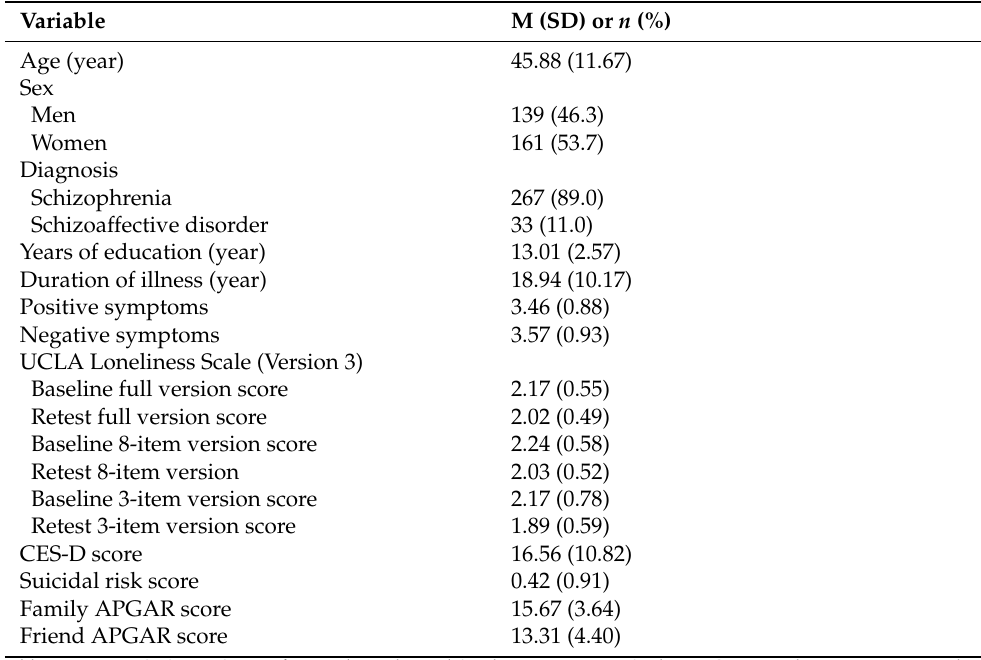
Table 1. Participant characteristics ( n =